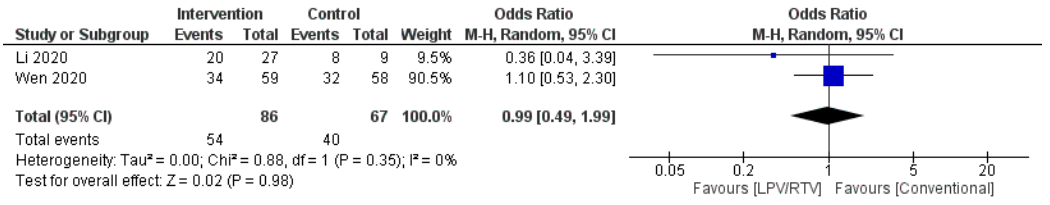
Figure 6. Time to body temperature normalization (days) (LPV / RTV vs. no antiviral treatment